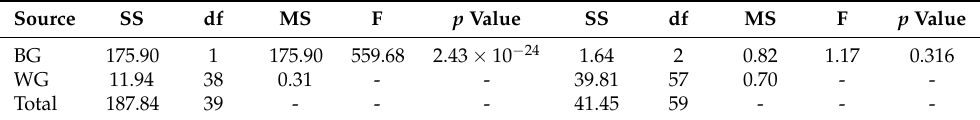
Table 5. Using the RRSYNTH dataset, the ANOVA results of the left side columns were obtained from the GBAMF and CAGBA; the right side columns were obtained from SVRMF, LSTMMF and GBAMF models.